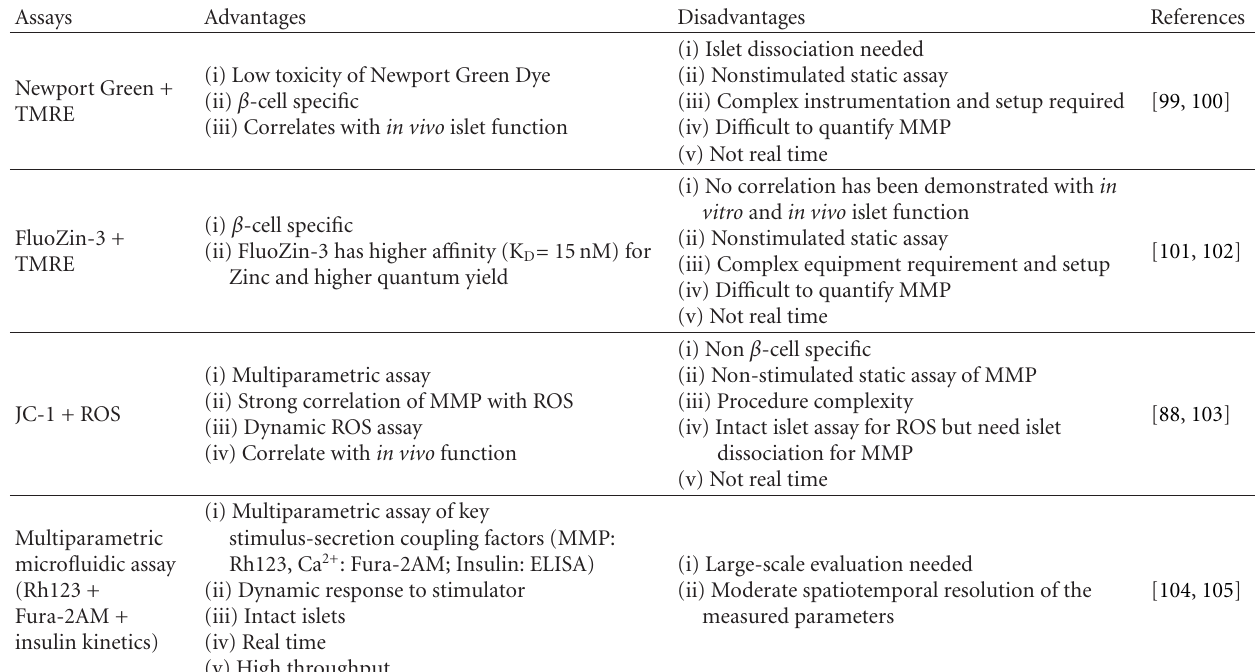
Table 3: Advantages and disadvantages of mitochondria-based islet potency and viability assays.